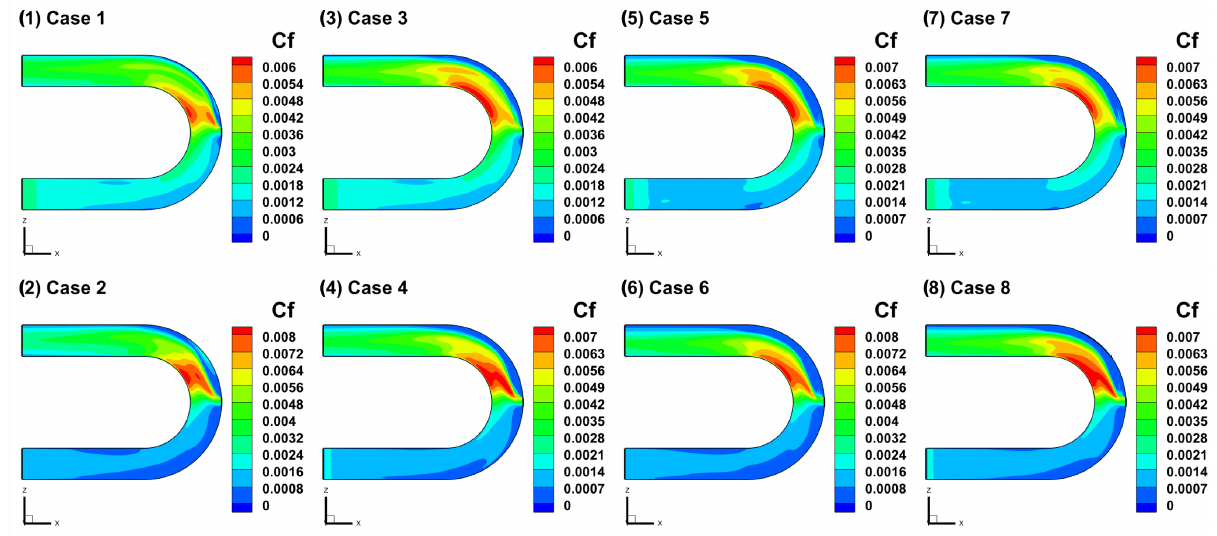
Figure 16. Contours of dimensionless bed shear stress friction coefficient C f in the main channel of all the cases.